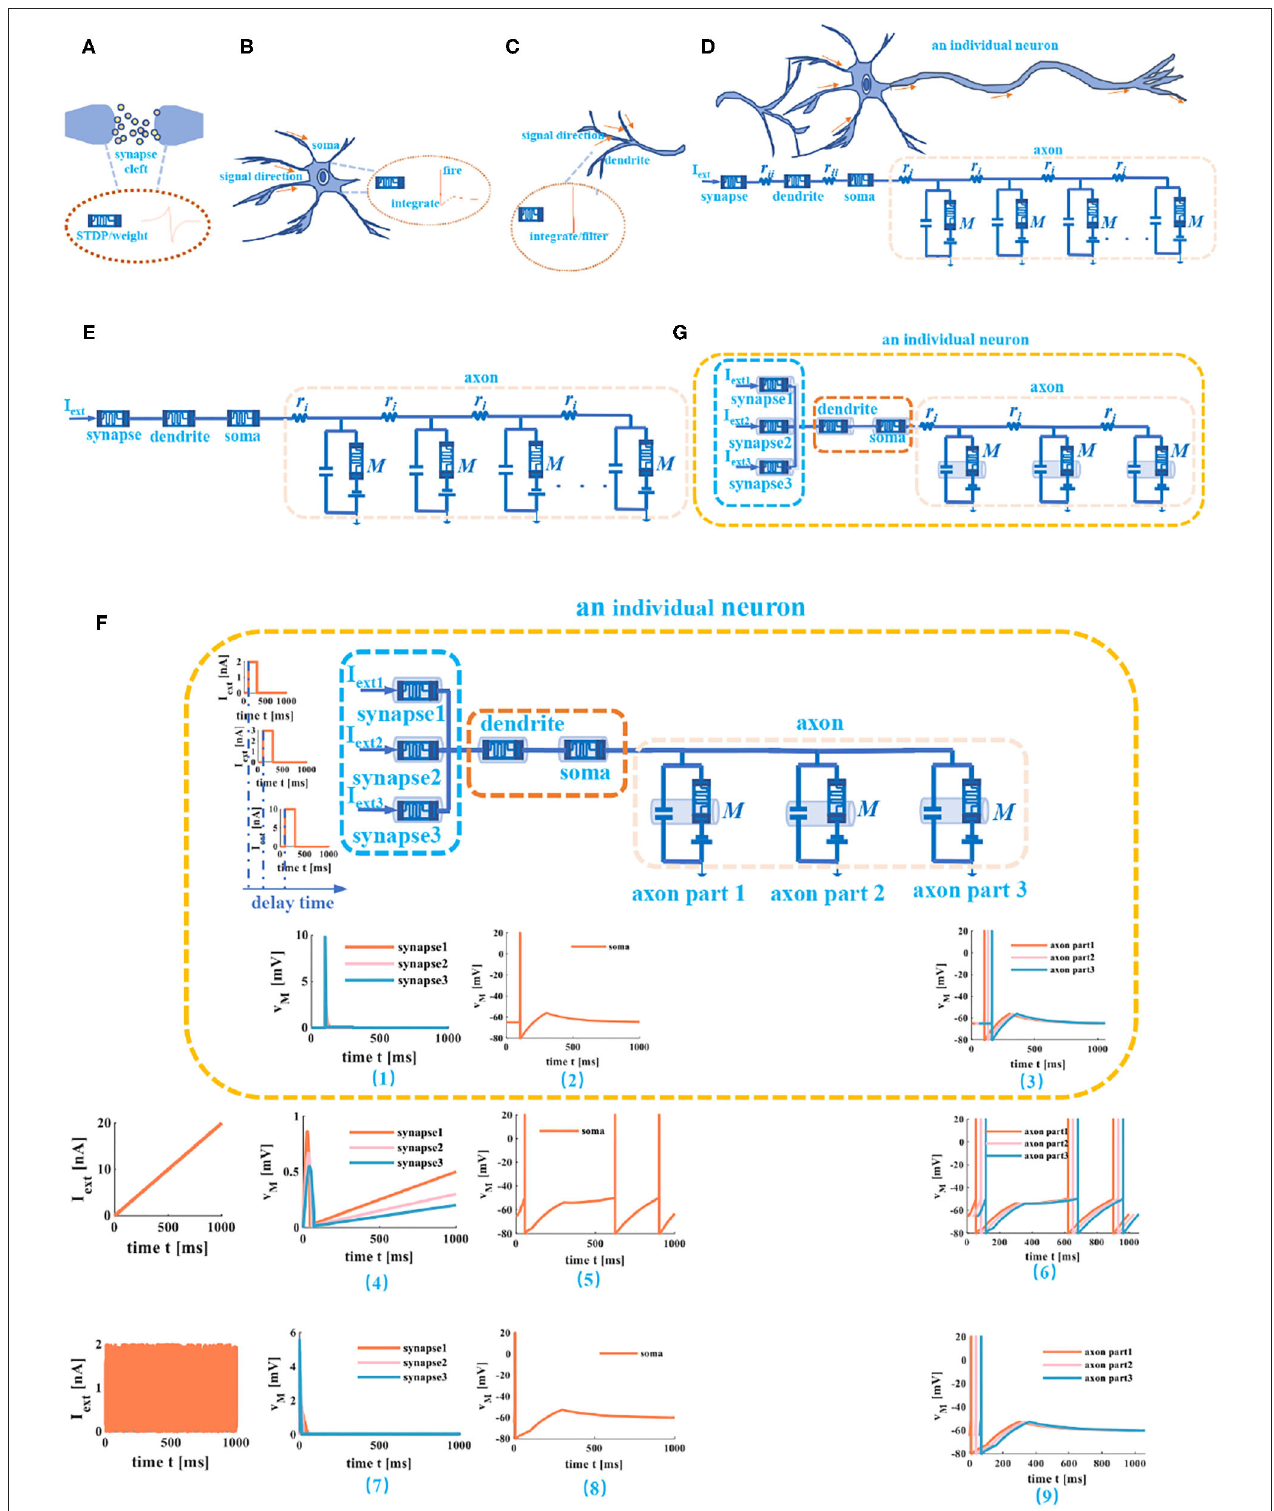
FIGURE 8 | Memristive cable model of a neuron. (A) The memristor used as the synapse. (B) The memristor is used as soma. (C) The memristor used as dendrite. (D) An individual neuron realized by memristive synapse, memristive dendrite, memristive soma, and memristive axon. (E) An individual neuron without the humoral resistance and the cytoplasmic resistance. (F) The three different current stimuli act on the compartmental circuit model of a neuron. (G) An individual neuron circuit model with three synapses.